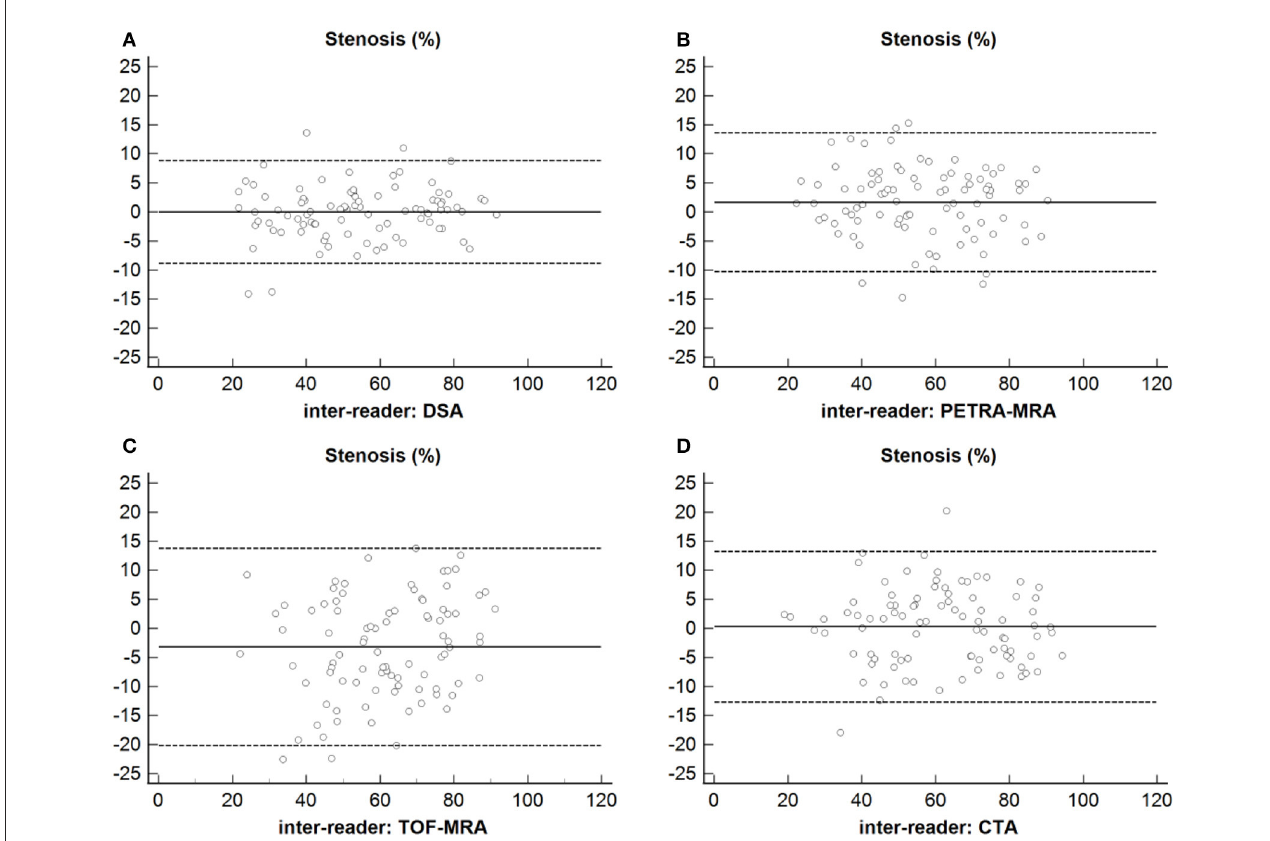
FIGURE8 Inter-reader agreement of the measurements of the degree of stenosis using DSA, PETRA-MRA, TOF-MRA, and CTA. (A) Stenosis: Inter-reader agreement of DSA. (B) Stenosis: Inter-reader agreement of PETRA-MRA. (C) Stenosis: Inter-reader agreement of TOF-MRA. (D) Stenosis: Inter-reader agreement of